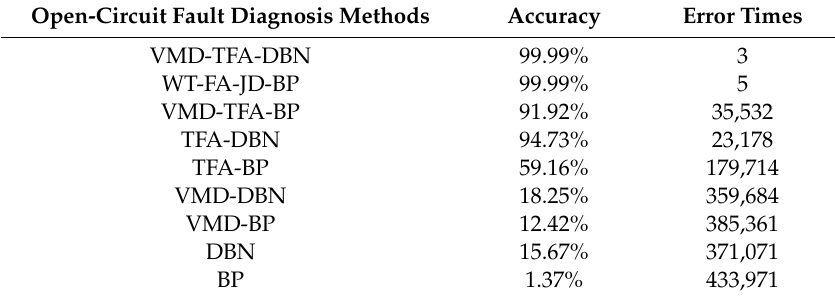
Table 9. The experimental comparison results of open-circuit fault diagnosis under 9